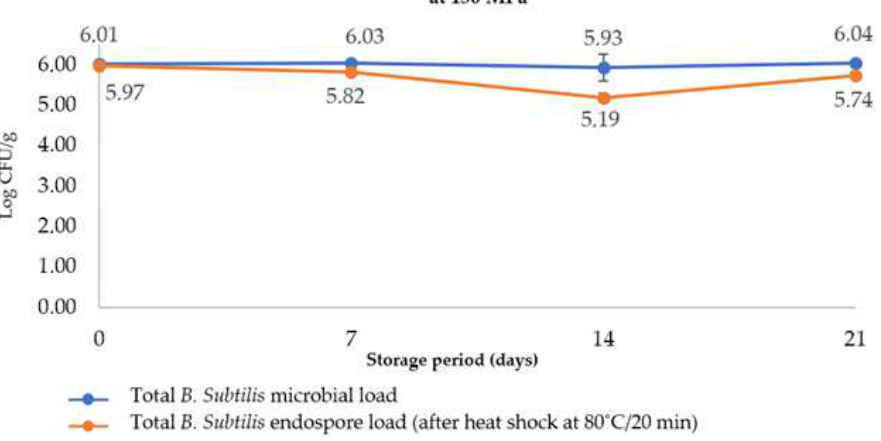
Figure 5. Effect of hyperbaric storage (HS) of inoculated HWP (honey–water preparation) with an adjusted water activity (a W = 0.80) at 150 MPa at uncontrolled room temperature (20–23 ◦ C) up to 21 days on the total B. subtilis microbial load (blue lines) and endospore load (orange lines, after a heat-shock of 80 ◦ C for 20